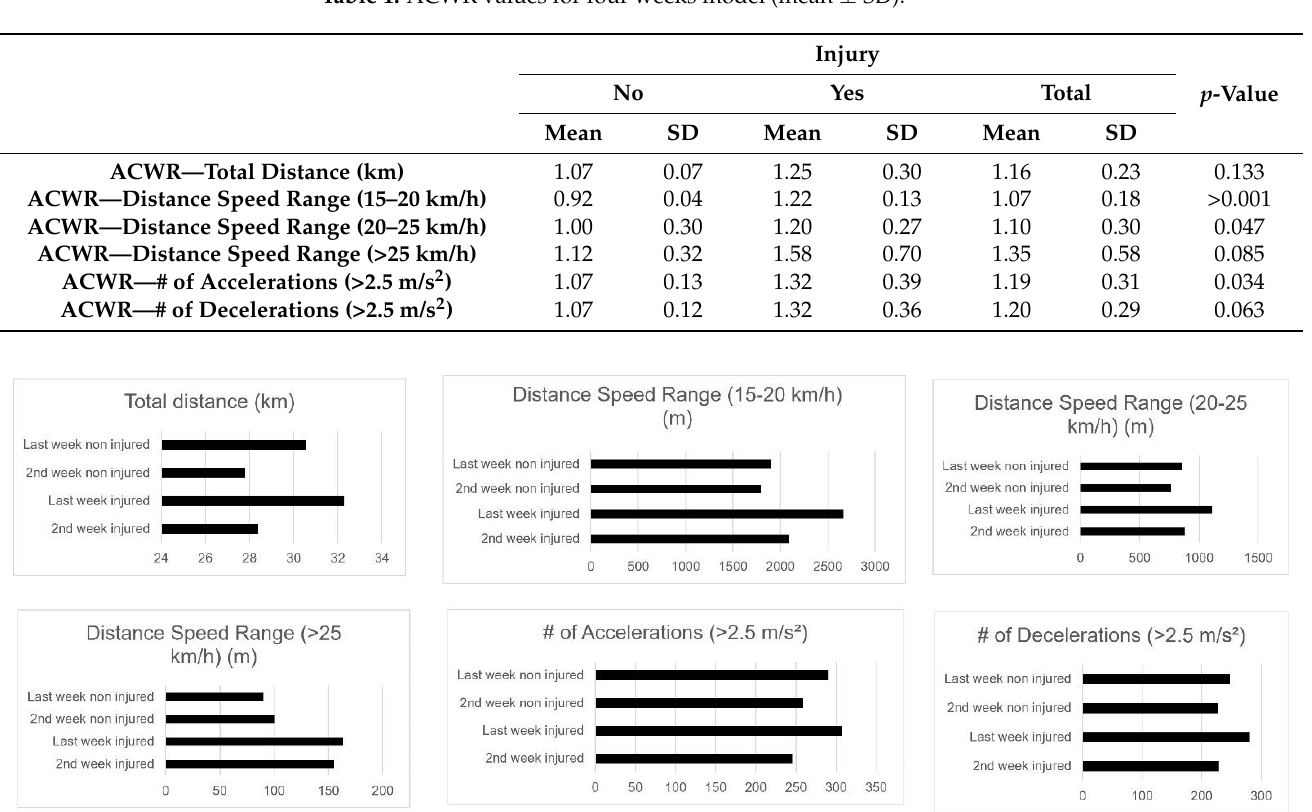
Figure 1. Values of injured and no injured soccer players for four-week model. # denotes number.